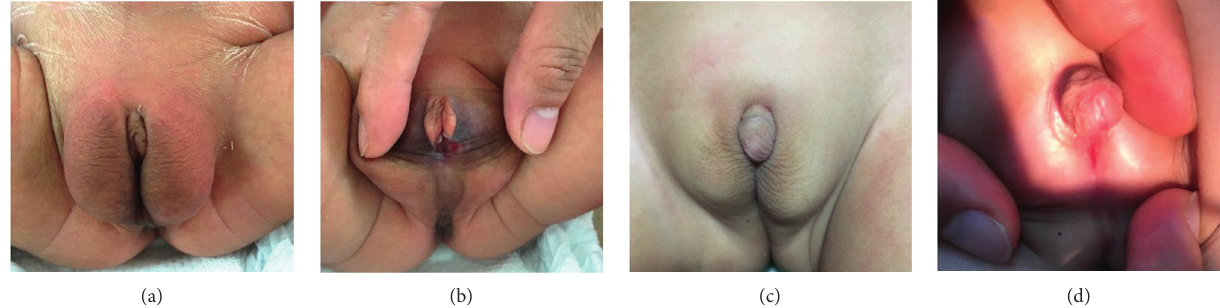
Figure 1: Patient’s abnormal genital phenotype: at the age of three days, (a) labia-majora-like bifid scrotum with clitoris-like microphallus and (b) perineoscrotal hypospadias; at the age of two years and three months, (c, d) microphallus had grown to 1.5 cm in